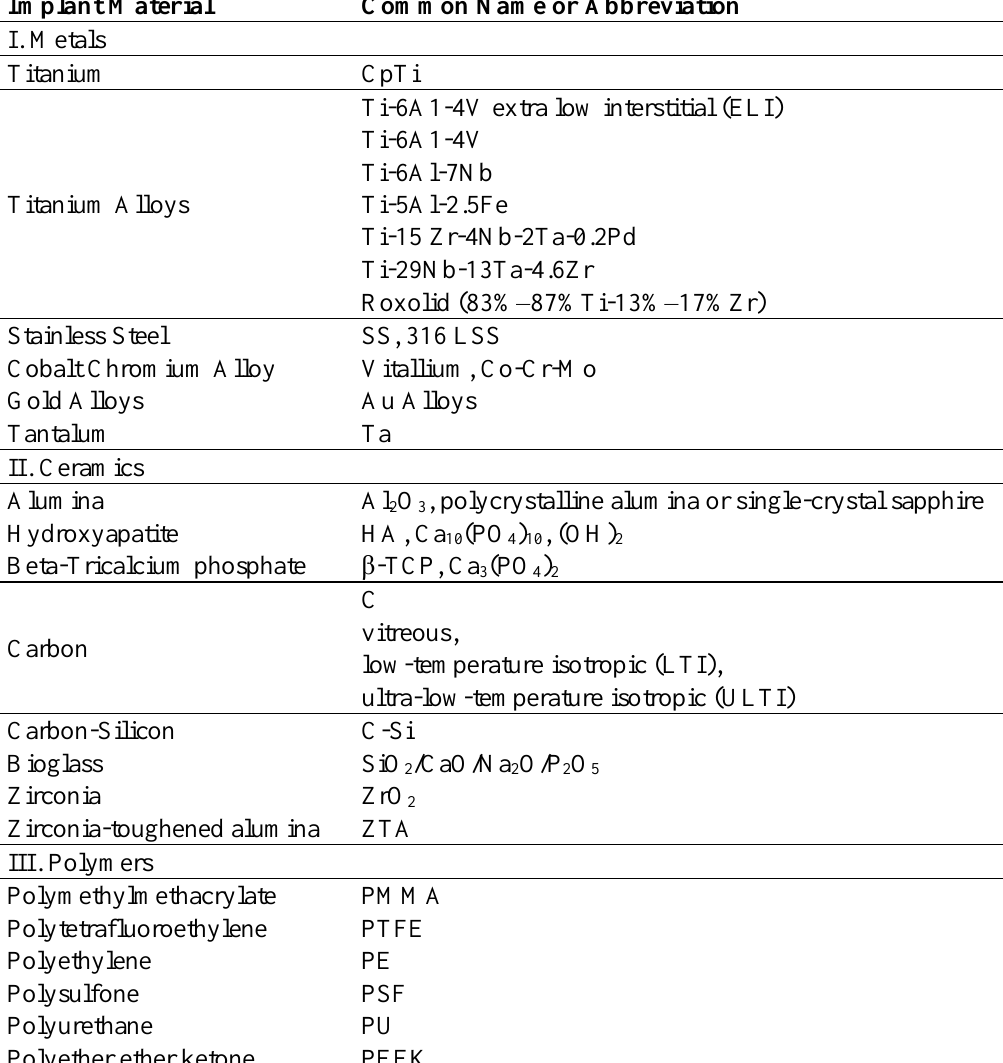
Table 1. Materials used for the fabrication of endosseous dental